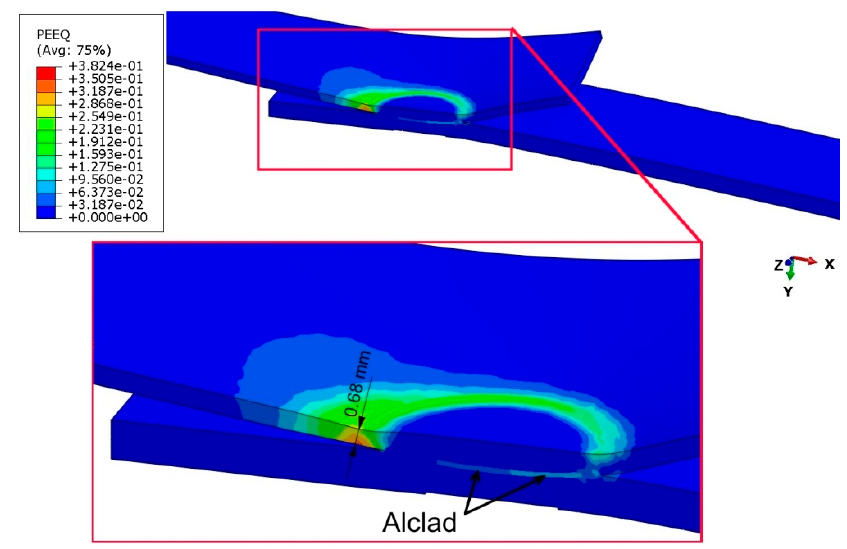
Figure 25. Distribution of equivalent plastic strain on the longitudinal cross-section of an RFSSW joint (experiment E2) under tensile shear loading at a displacement of 1.9 mm.